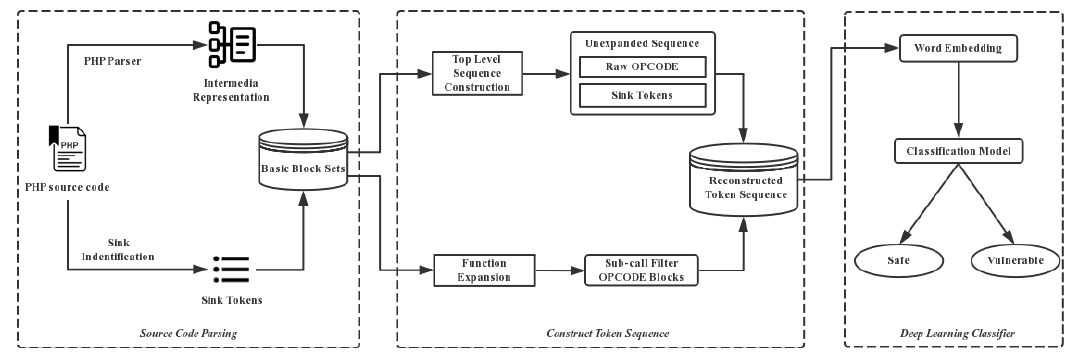
Figure 1. The architecture of the proposed